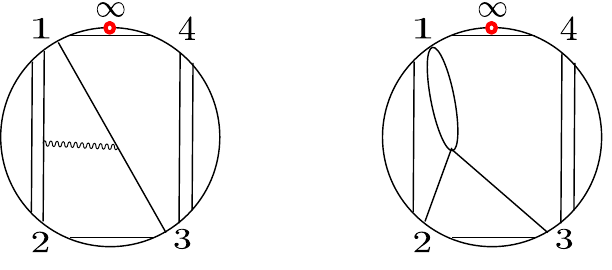
Figure 13 . Examples of one-loop diagrams for the four-point function without diagonal contrac- tions ( ‘ 13 = ‘ 24 = 0). The (cid:12)rst two diagrams are the gluon-exchange diagrams while the third and the fourth diagrams are Q (cid:0) and Q + . 1234 1234